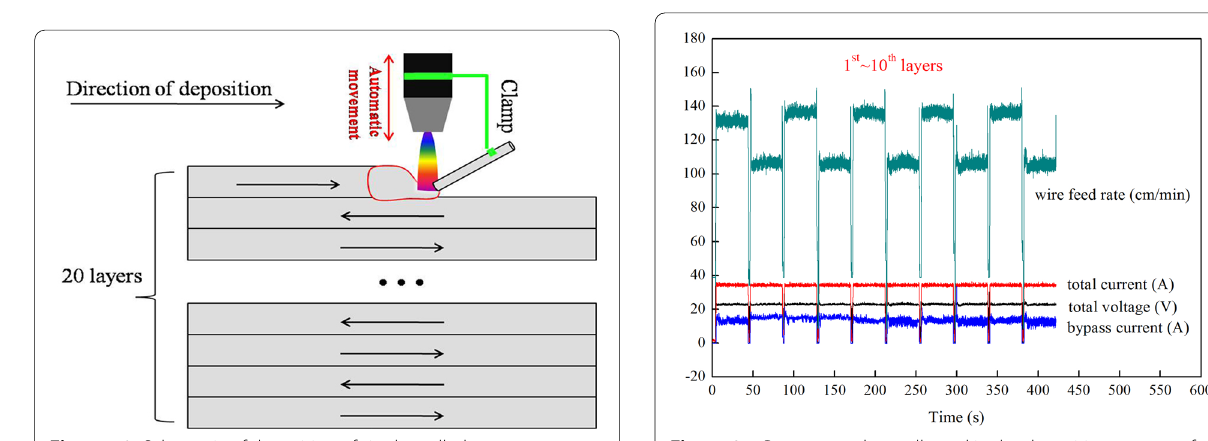
Figure 21 Parameters data collected in the deposition process of the 1st ‒ 10th